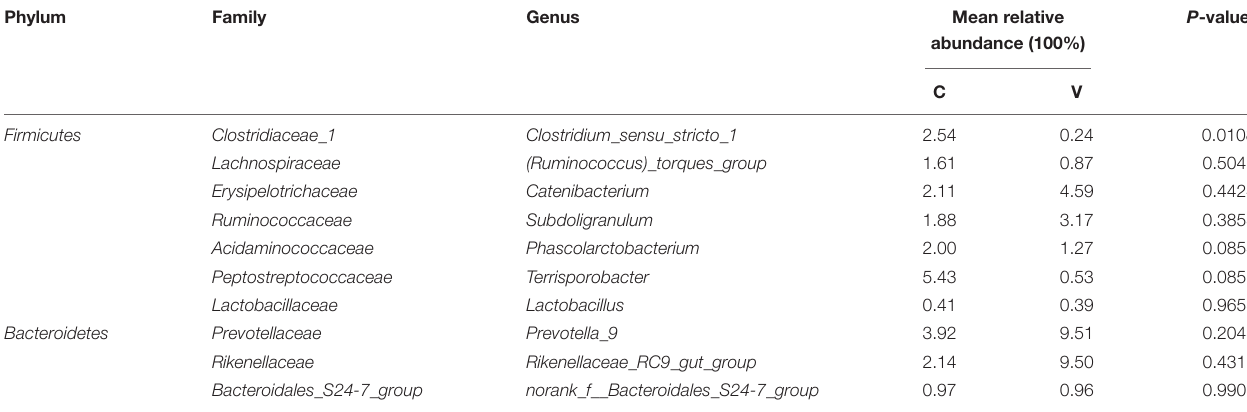
TABLE 1 | Comparisons of 10 core genera between porcine circovirus type 3 (PCV3)- (V) and sham-inoculated (C) piglets at 21 dpi. Phylum Family Genus Mean relative P -values